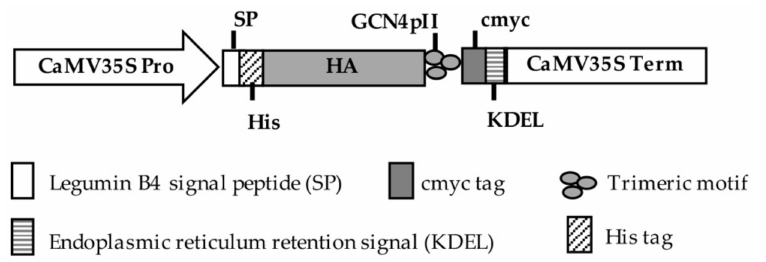
Figure 2. Expression cassettes of haemagglutinin (HA) proteins in